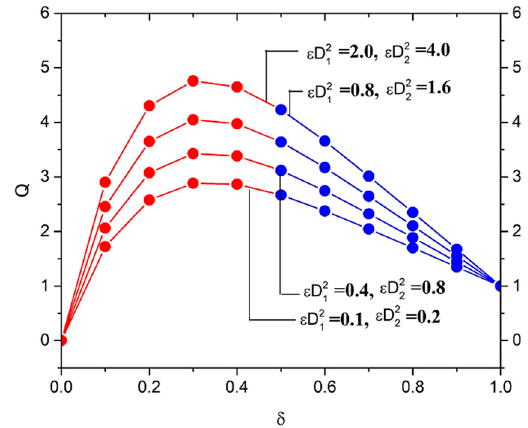
Figure 6. Effect of ε𝐷 (cid:2869)(cid:2870) and ε𝐷 (cid:2870)(cid:2870) on volume flow rate when 𝑋 (cid:2869) = 0.5, 𝑋 (cid:2869) = 1.0.